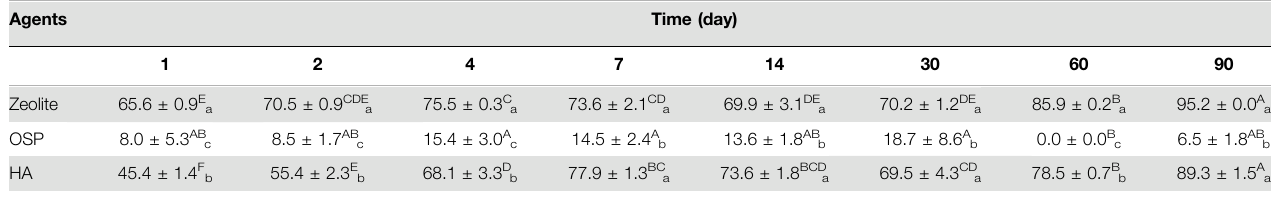
TABLE 4 | The removal ef fi ciency (%) of 1000 μ g/L of MG in seawater treated with three agents (200 mg/L) at observation point during 90 days. Agents Time (day)